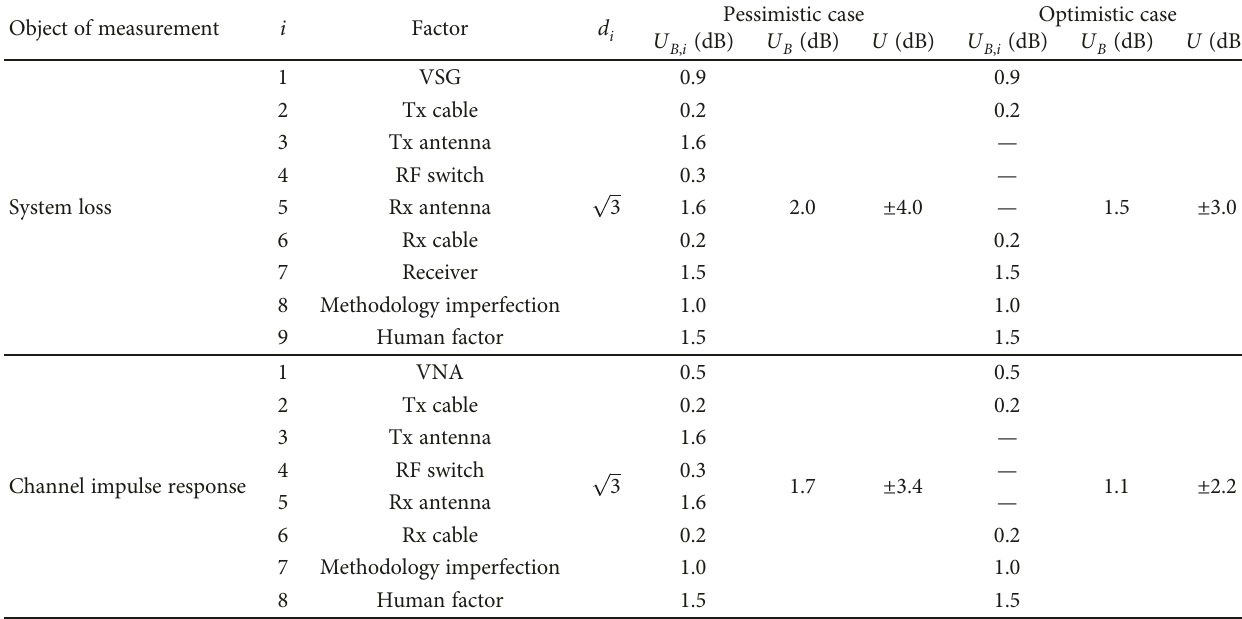
Table 1: Evaluation of the standard uncertainty and expanded uncertainty for 95% con fi dence interval ( k = 2 ). Object of measurement